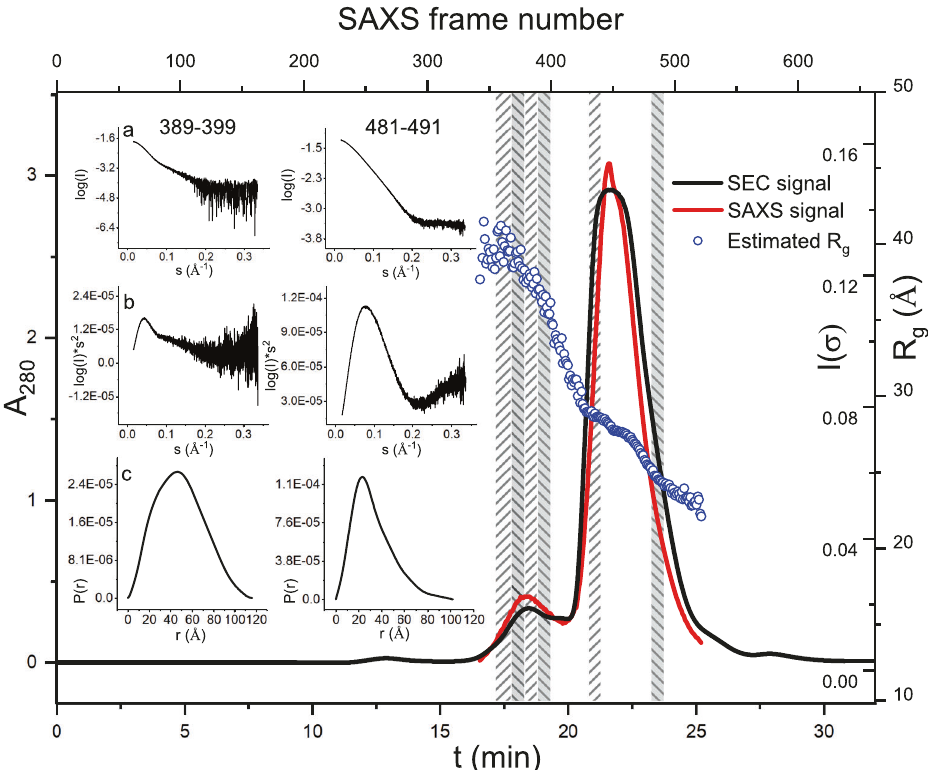
Fig. 5 | SEC-SAXS analysis of NKR-P1:LLT1 shows higher-order complex for- mation. Overlay of the size-exclusion chromatography pro fi le (black line) and SAXSscattering signal(redline)fortheNKR-P1:LLT1 equimolarmixtureata15mg/ mlloading concentration.Both signalsshowtwo distinctpeaks.For eachcollected SAXSframe,theradiusofgyrationwascalculatedusingAUTORG(bluecircles).For furtheranalysis,sixintervalsoftheSAXSdatawereselectedandseparatelymerged